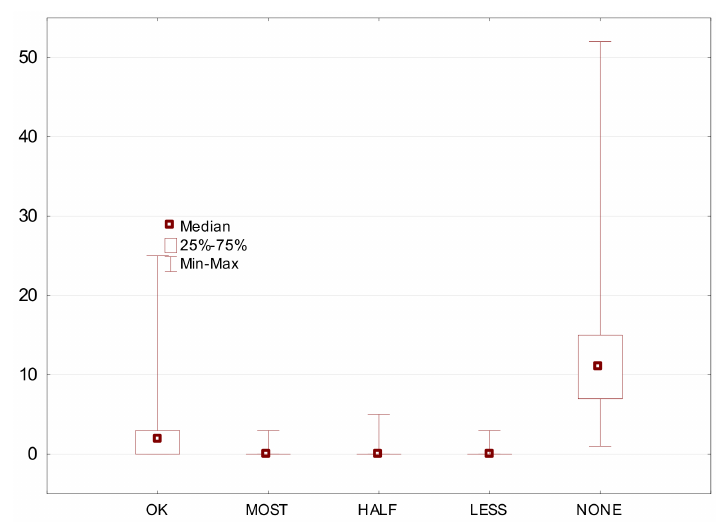
Figure 2. Median, quartiles, minimum, and maximum of place names classified as OK, Most, Half, Less, and None in